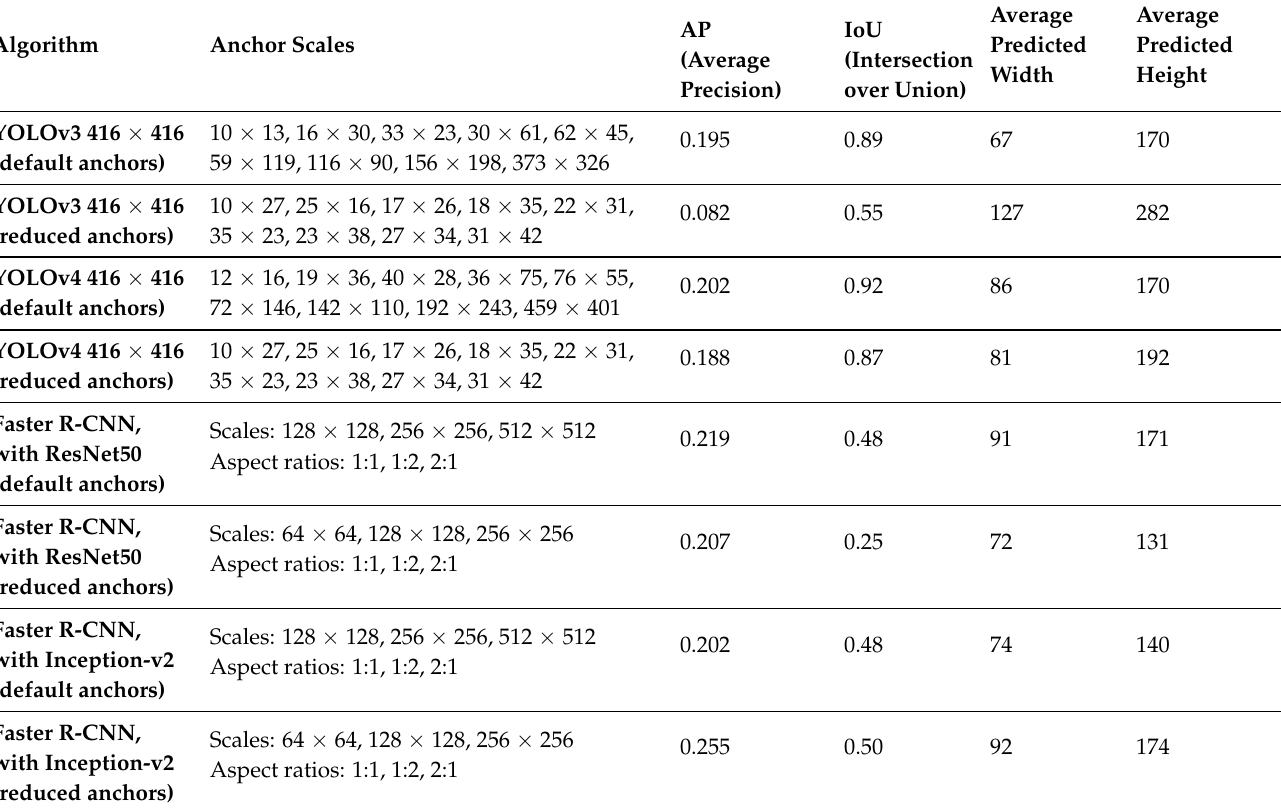
Table 12. Effect of reducing the anchor scales of YOLOv4, YOLOv3, and Faster R-CNN on the Stanford Dataset.